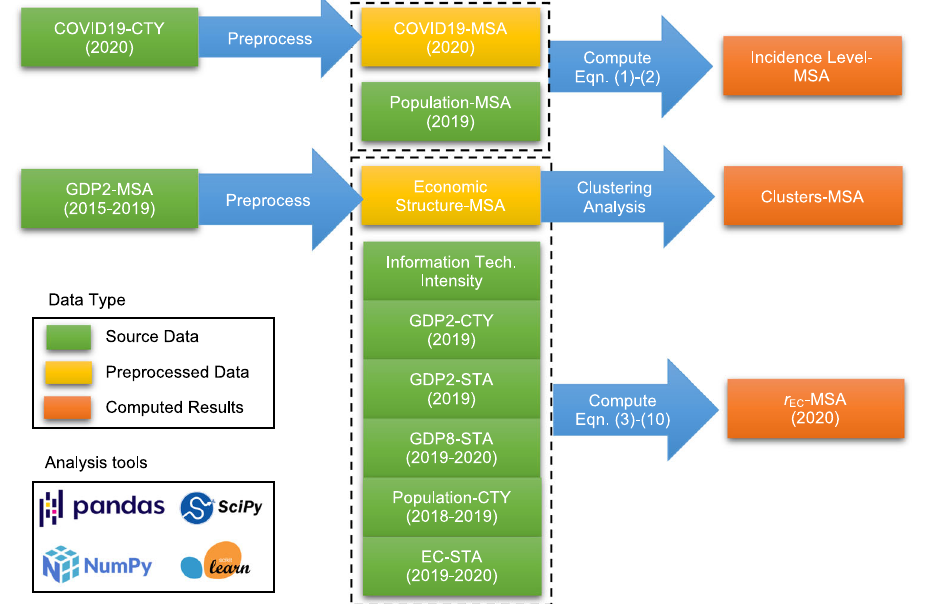
the raw source data and computation results can be found in the Data availability